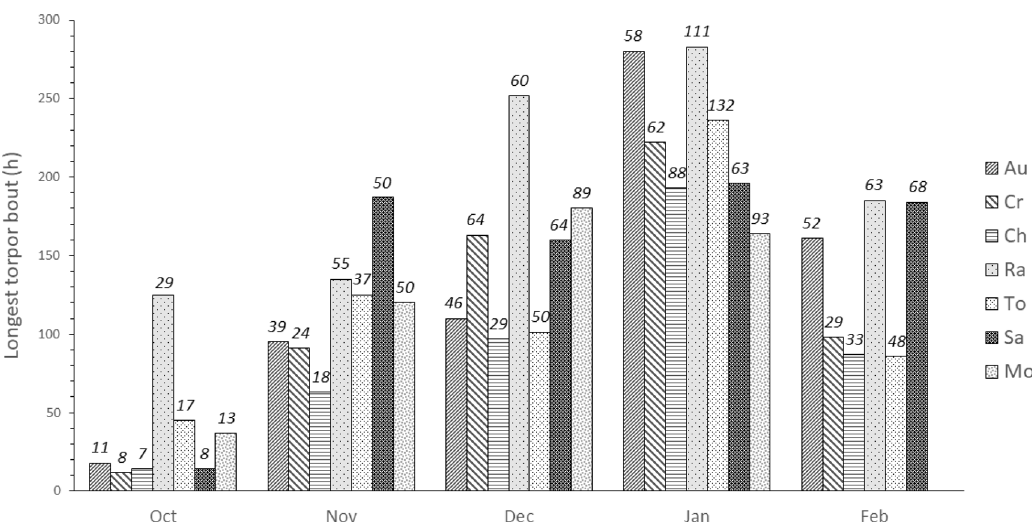
Figure 2. Longest individual torpor bout (bars) and mean torpor bout duration (values above bars) in hours, per individual and